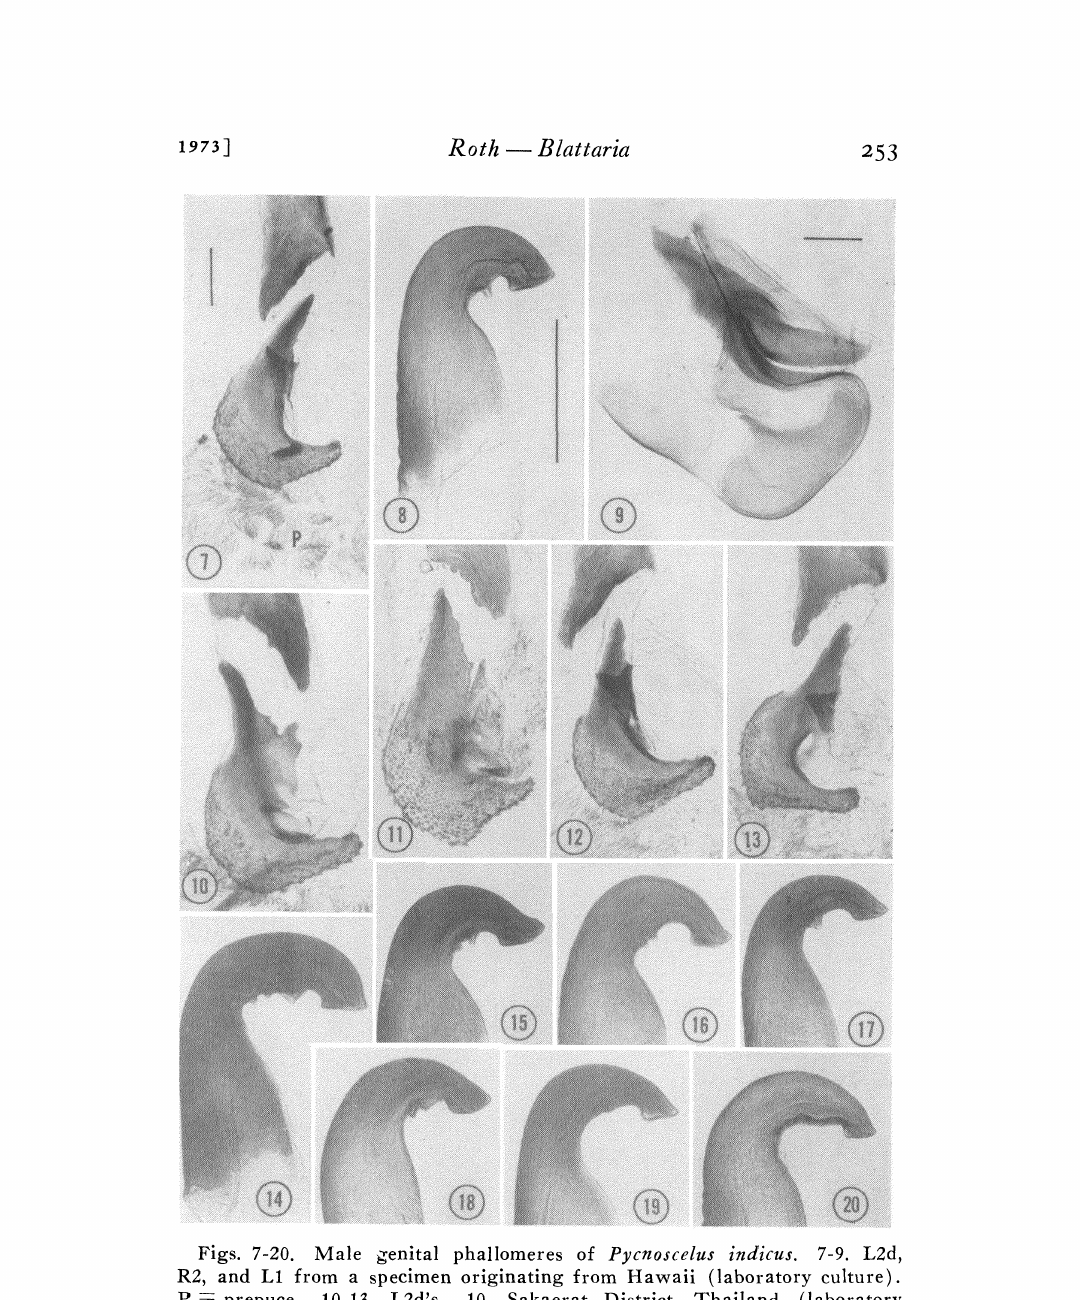
Figs. 7-20. Male genital phallomeres of Pycnoscelus indicus. 7-9. L2d, R2, and L1 from a specimen originating from Hawaii (laboratory culture). P prepuce. 10-13.